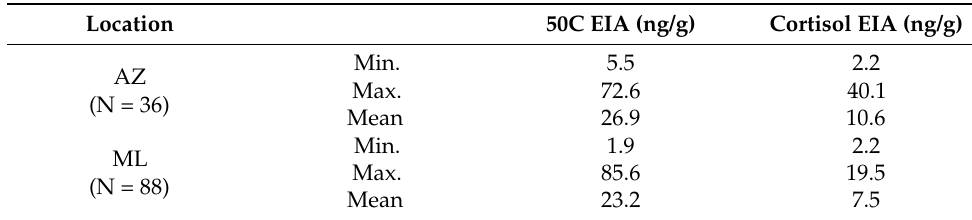
Table A1. Summary statistics for FCM (faecal cortisol metabolite) levels (ng/g) measured by 50c and cortisol EIAs (enzyme immunoassays) for control koalas in each location (AZ = Australia Zoo